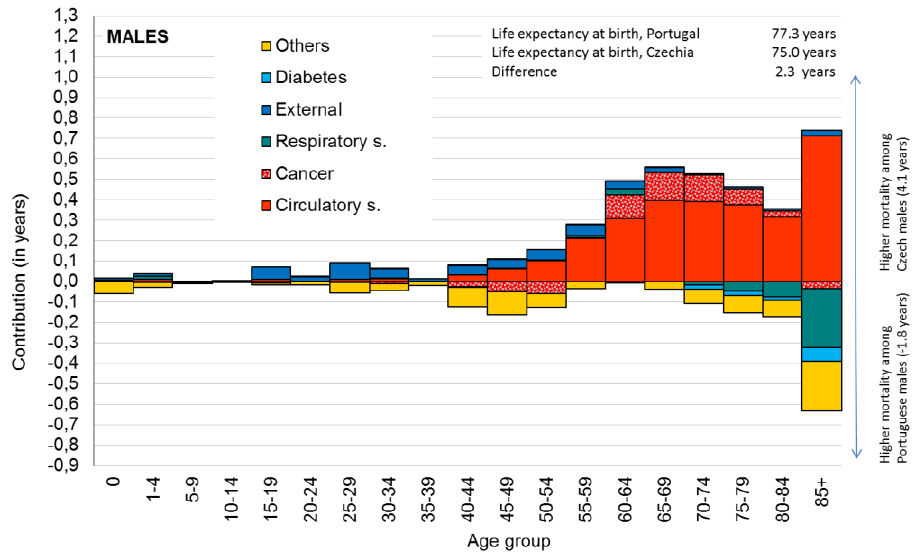
Figure 2. Contribution of age-specific mortality for selected groups of causes to differences in male life expectancy at birth, Portugal vs. Czechia, 2012. Data source: Human Mortality Database. University of California, Berkeley (USA), and Max Planck Institute for Demographic Research (Germany). Available at www.mortality.org or www.humanmortality.de (data downloaded on 13 March 2017). WHO mortality database. (March 2017).